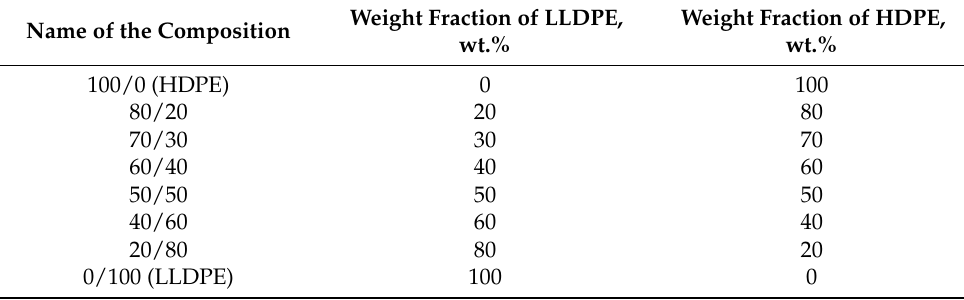
Table 3. The data on the weight ratio between the binary HDPE–LLDPE